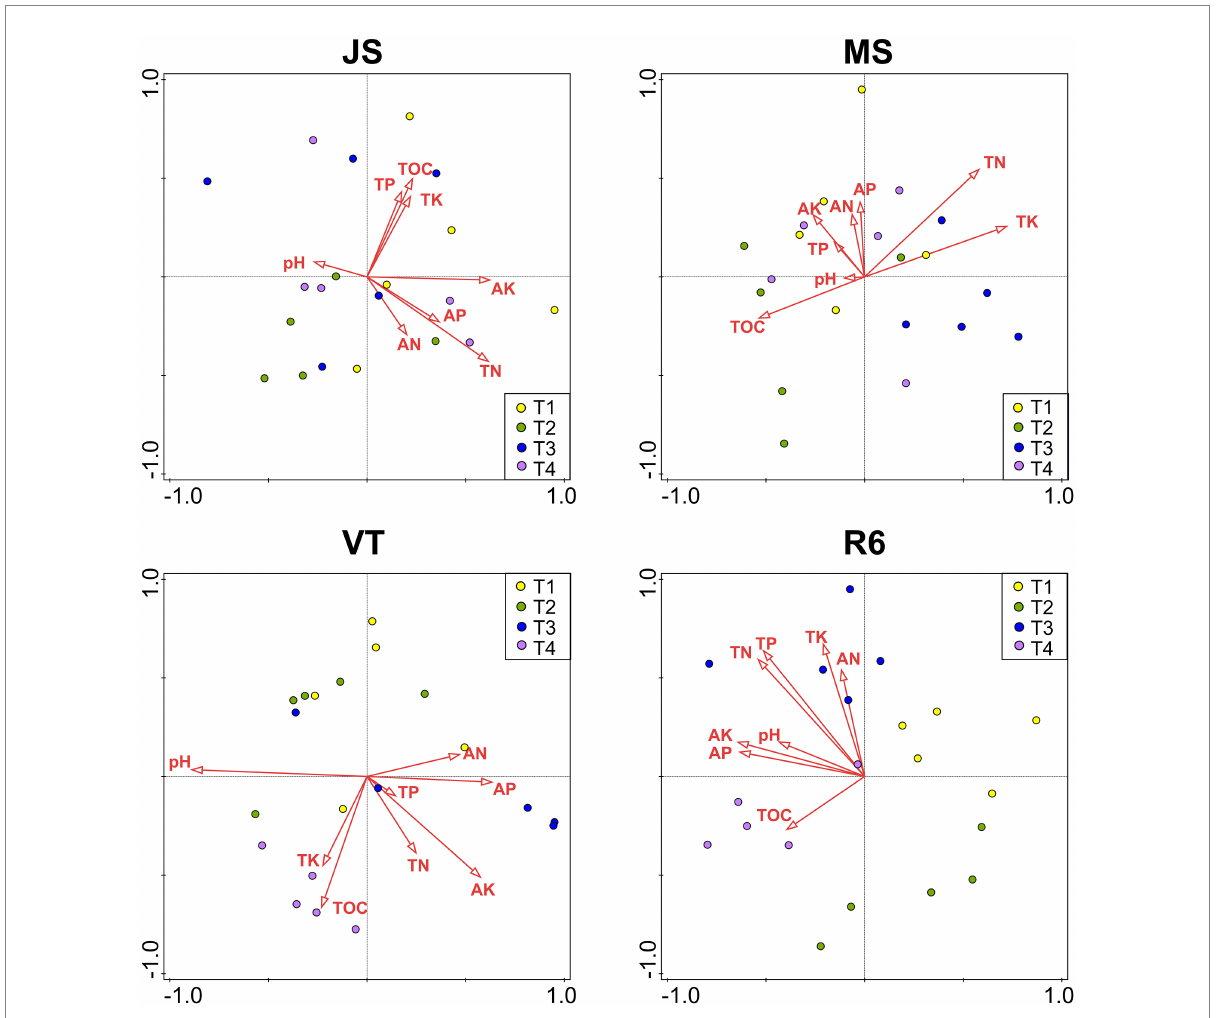
FIGURE 5 RDAs between the bacterial community of all OTUs with soil characteristics. JS, jointing stage of wheat; MS, maturity stage of wheat; VT, tasseling stage of maize; R6, maturity stage of wheat; TOC, soil total organic carbon; TN, total nitrogen; AN, alkali-hydrolyzed nitrogen; TP, total phosphorus, AP, available phosphorus, TK, total potassium, AK, available